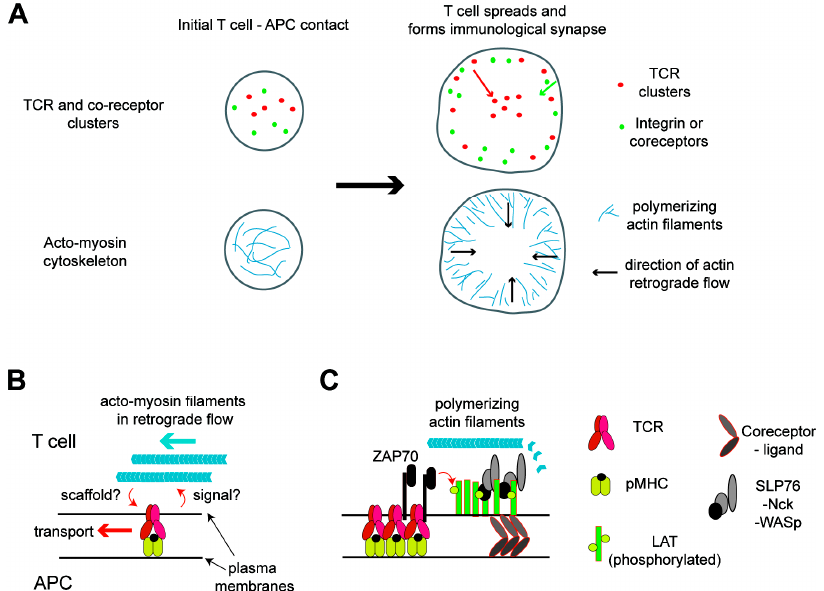
Figure 1. Acto-myosin cytoskeleton network in activated T cells and its roles in signaling and molecular transport. ( A ) Distribution of the T cell receptor (TCR) and actin at the interface between the T cell and antigen-presenting cell (APC). At the initial contact of the two cells, the TCR and coreceptors nucleate the clusters by binding to their ligands and cortical actin nucleates. This active actin polymerization induces the spreading of the T cell over the APC soon after, resulting in the formation of a lamella structure at the periphery. Polymerized acto-myosin filaments exhibit a retrograde flow in the lamella. These filaments function as scaffolds or induce the transport of protein clusters toward the cell center. The TCR moves a longer distance to the center, while the coreceptors and integrin remain in the periphery, resulting in a bull’s eye pattern of the immunological synapse. ( B ) TCR proximal signaling leads to the nucleation of actin filaments, which, in turn, function as scaffolding in the protein cluster transport. ( C ) Details in the link between the TCR and actin. ZAP70 recruited to the phosphorylated immunoreceptor tyrosine-based activation motifs (ITAMs) in the TCR-CD3 complexes phosphorylates tyrosine residues in the linker for the activation of T cells (LAT). Then, signalsome proteins, such as SLP76, Nck, and WASp, are recruited to the phosphorylated LAT to form molecular condensation, which is likely colocalized with the TCR at least for a short period of time and can also be colocalized with coreceptor domains. These protein clusters can nucleate actin filaments, which can sca ff old the clusters temporarily. pMHC: peptide major histocompatibility